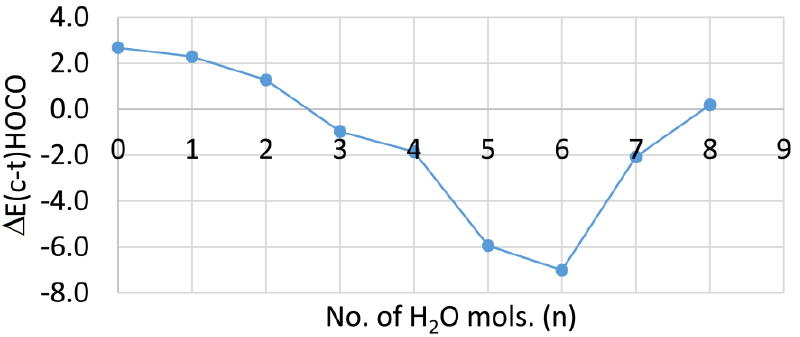
Figure 4. Graph of the Difference in the Energies (kcal/mol) of the 1Hc and 1Ht hydrated clusters as a function of the number of cluster water molecules.